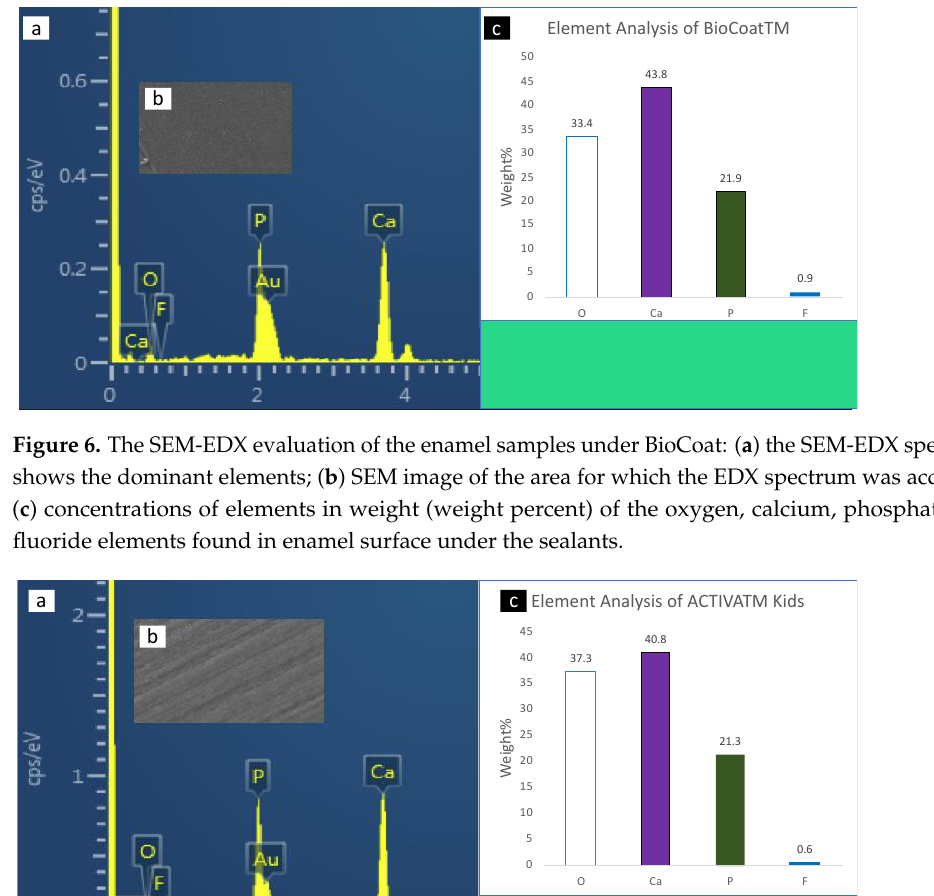
Figure 5. The SEM-EDX evaluation of the enamel samples under Seal-it: ( a ) the SEM-EDX spectrum shows the dominant elements; ( b ) SEM image of the area for which the EDX spectrum was acquired; ( c ) concentrations of elements in weight (weight percent) of the oxygen, calcium, phosphate and fluoride elements found in enamel surface under the sealants.